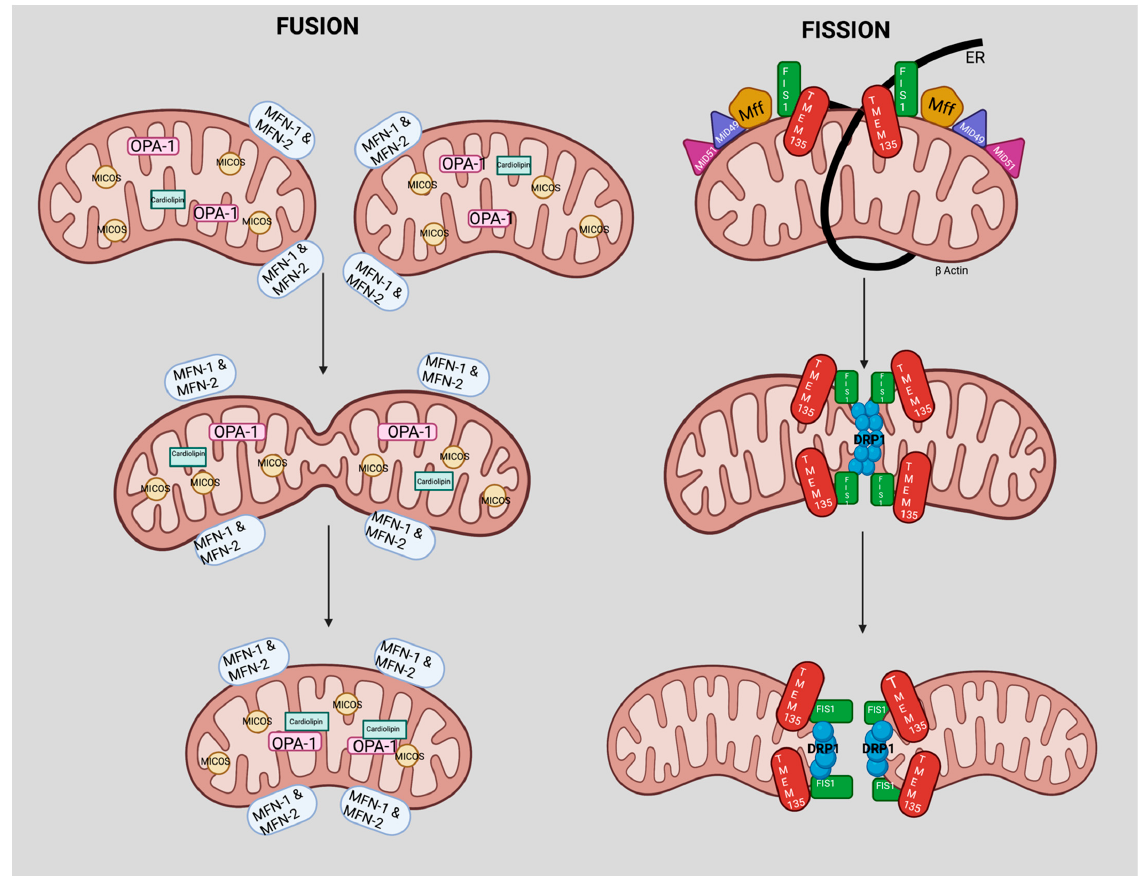
Figure 4. We hypothesize a role of TMEM135 in fission due to Ca 2+ influx into the mitochondria and stimulation of DRP1- dependent mitochondrial fission. Mitochondrial dynamics are split into two processes: Fusion and Fission. Mitochondrial fusion is coordinated by Mitofusin 1 (MFN-1) and Mitofusin 2 (MFN-2) [light blue color], Optic Atrophy 1 (OPA-1) [light pink], Mitochondrial contact site and cristae organizing system (MICOS) [light yellow], and Cardiolipin [light green]. Mitochondrial fission proteins are coordinated by Mitochondrial Fission 1 protein (FIS1) [green], Mitochondrial dynamic protein of 51 kDa homolog (MiD51) [magenta] and Mitochondrial Fission Factor of 49kDA homology (MiD49) [purple], Mitochondria fission factor (Mff) [dark yellow], Transmembrane Protein 135 (TMEM135) [red] on the outer membrane of the mitochondria; whereas, Dynamin-1-like protein 1 (DRP1) [blue] is located in the inner membrane of the mitochondria. The endoplasmic reticulum (ER) [black] is represented in the fission process. It cannot be ruled out that TMEM135 plays a role in regulating the balance between mitochondrial fusion and fission since it has been proposed that TMEM135 activates DRP1 [12]. Figure created with BioRender.com (accessed on 15 June 2021).